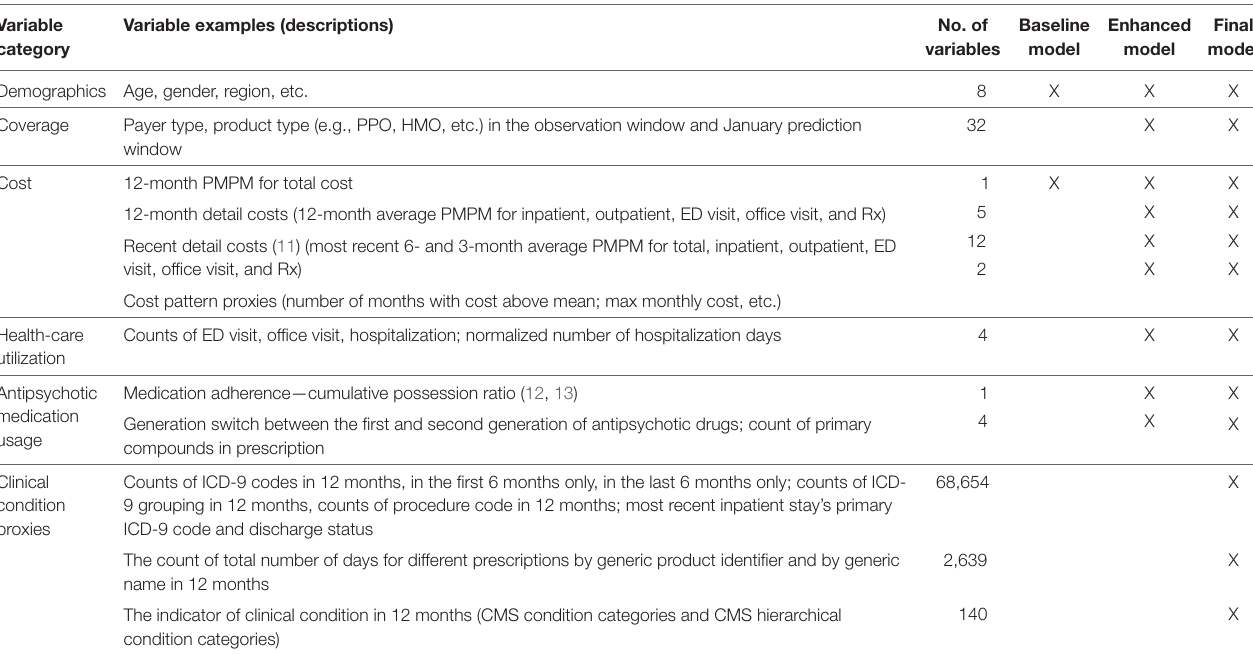
TaBle 1 | Variables investigated in the three models